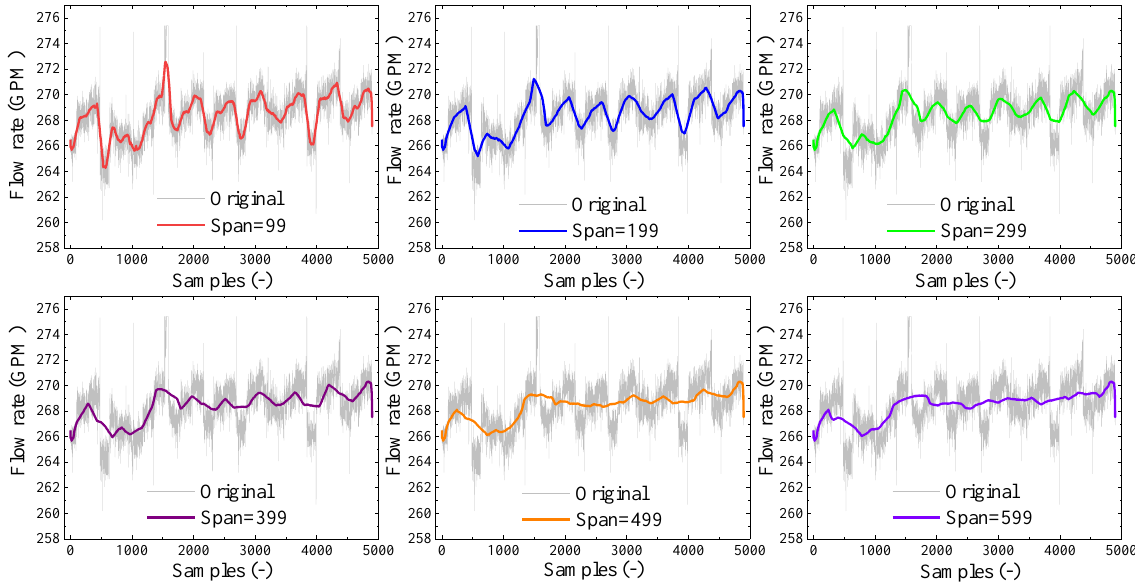
Figure 10. Data smoothing results when the parameter of the MA method is set too large.